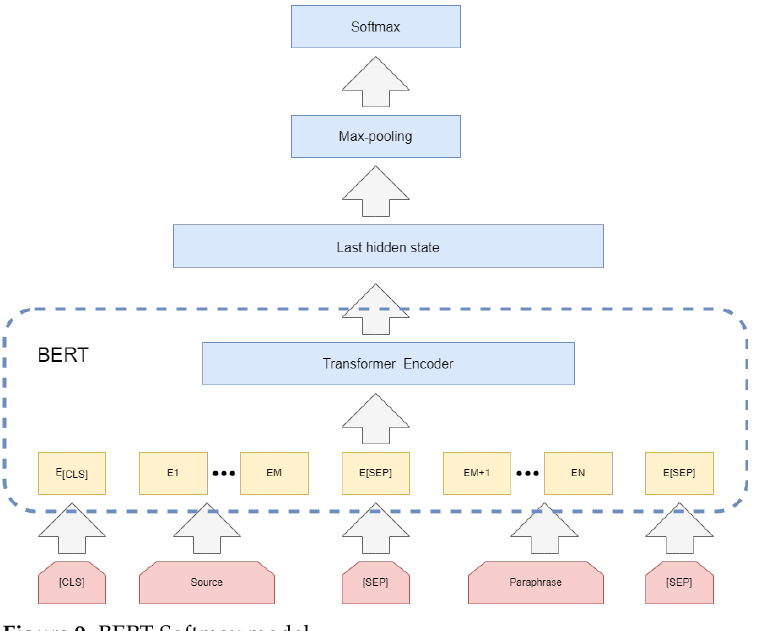
Figure 9. BERT-Softmax model.